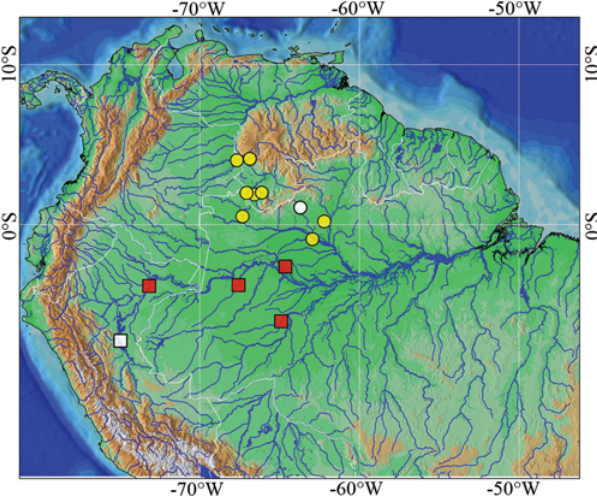
Fig. 10. Distribution of the species of Liosomadoras , L. oncinus represented by yellow circles, and L. morrowi by red squares. Type locality represented by open